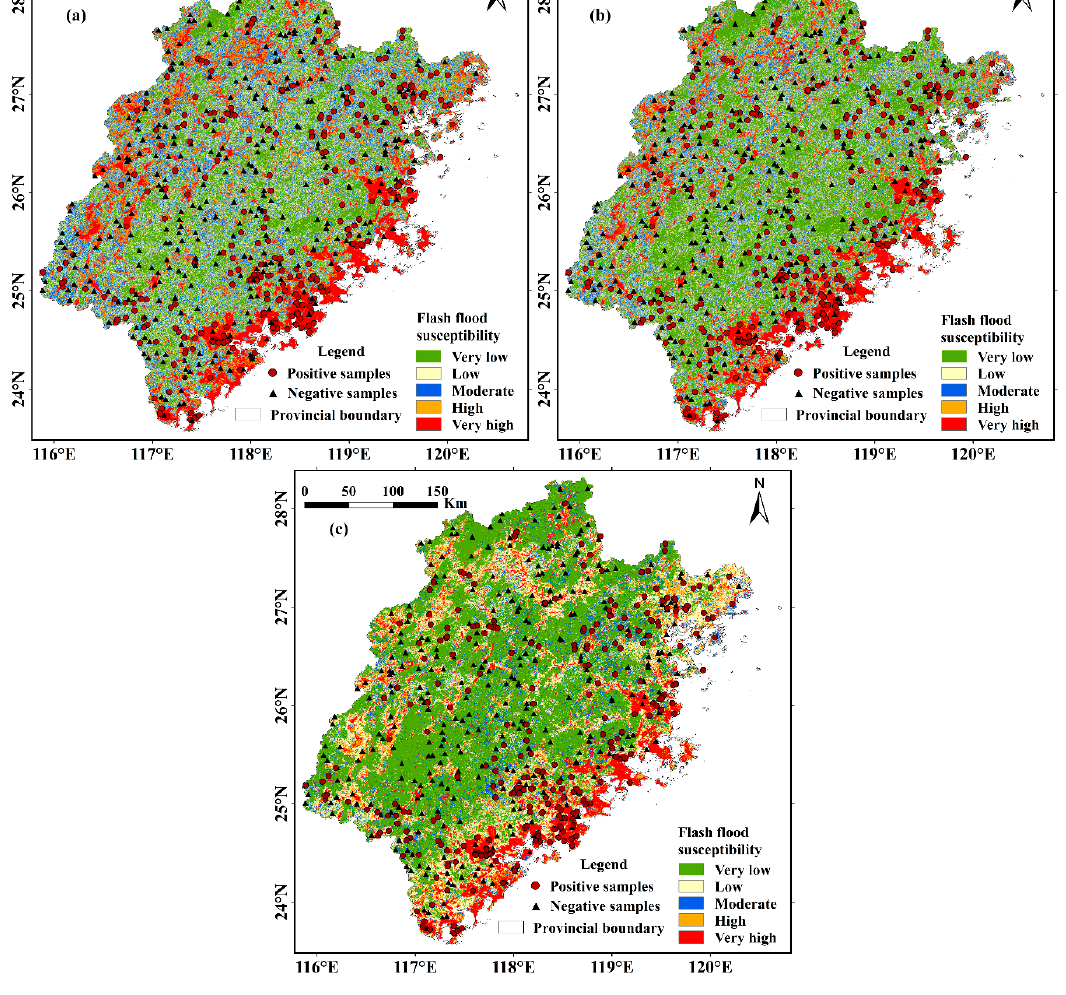
Figure 5. A histogram showing the percentages of ( a ) the validation points and ( b ) the flash flood zones obtained using the three models. On the other hand, the receiver operating characteristic (ROC) curve was selected to assess the accuracy of the model. The x-coordinate of the ROC curve represents the true positive rate (1 − specificity), and the y-coordinate represents the false positive rate (sensitivity). The range of the area